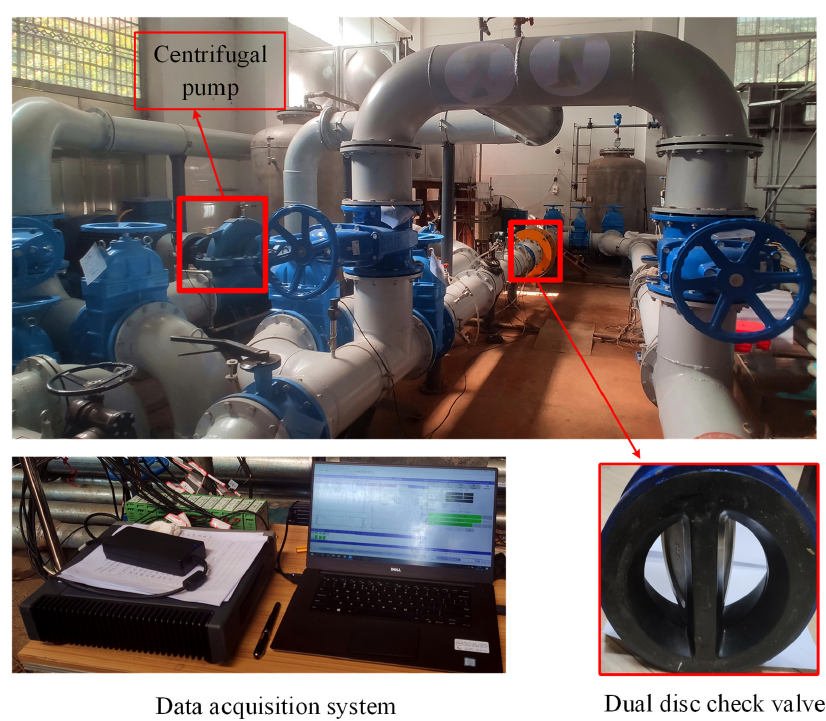
Figure 7. Physical picture of the dual disc check valve test bench.